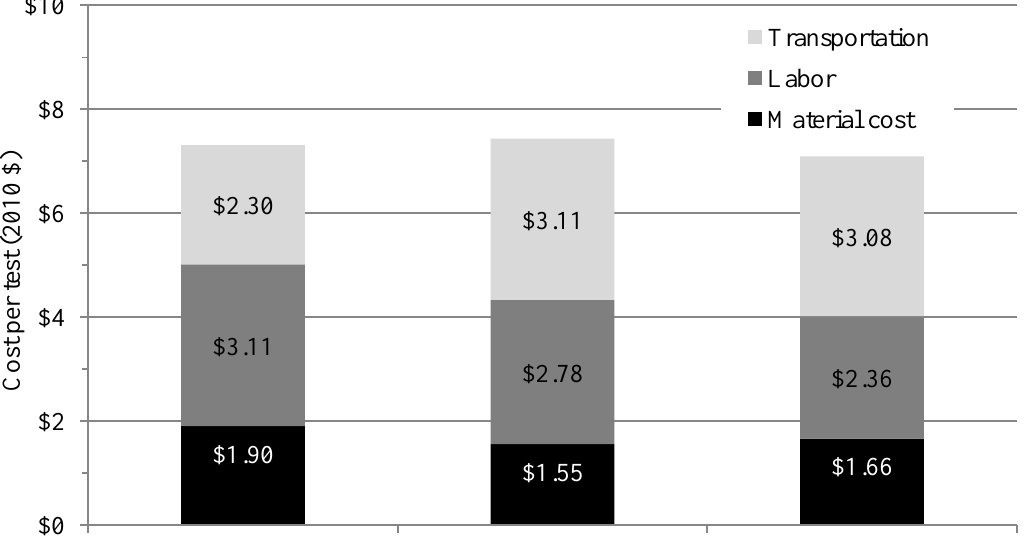
Figure 4. Marginal cost per test for three scenarios averaged across nine